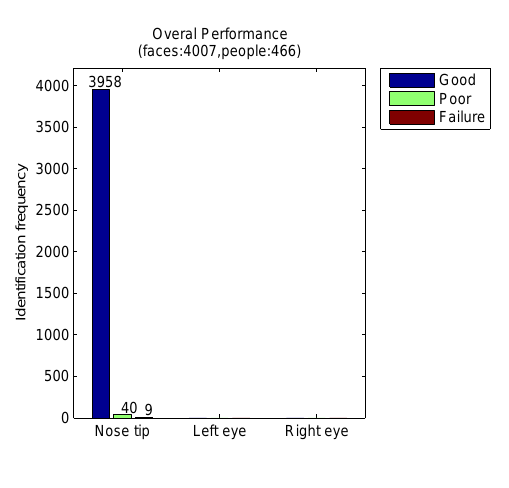
Fig. 16. Error distance curves for the nose tip identification of all faces.